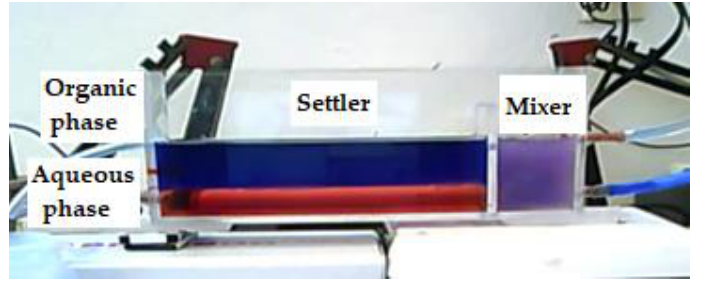
Figure 2. Mixer-settler for continuous process.